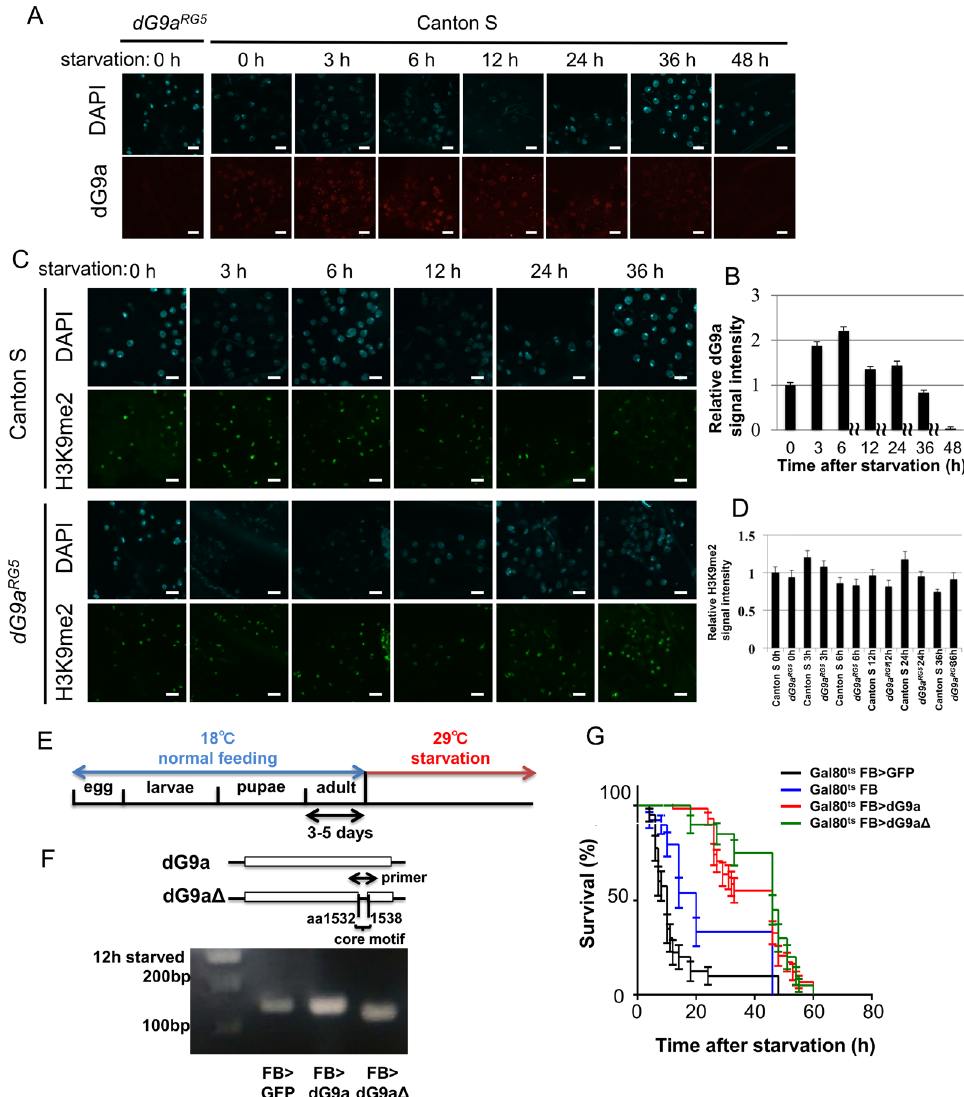
Figure 2. dG9a function in the fat body is critical for adult fly viability under starvation stress. ( A ) Transient induction of dG9a in the adult fat body under starvation conditions. Fat bodies of the wild-type and dG9a RG5 mutant were immunostained with an anti-dG9a antibody (red) and stained with DAPI (cyan). The dG9a RG5 mutant was used as a negative control. ( B ) Quantification of dG9a signals in nuclei of the wild-type fat body. Values were adjusted by subtracting background fluorescence n = 10. ( C ) Quantification of H3K9me2 signals in nuclei of the wild-type and dG9a RG5 mutant fat bodies. Values were adjusted by subtracting background fluorescence (n = 10). ( D ) H3K9me2 signal in the adult fat body under starvation conditions. Fat bodies of the wild-type and dG9a RG5 mutant were immunostained with an anti-H3K9me2 antibody (green) and stained with DAPI (cyan). ( E ) The experimental design of dG9a overexpression under starvation conditions. ( F ) Confirmation of dG9a and dG9a Δ 1532–1538 overexpression by semi-quantitative RT-PCR after 12 h of starvation. The primer included the core motif of the SET domain of dG9a. dG9a was more strongly expressed in FB > dG9a (FB-GAL4/GAL80 ts. α Tub84B ; UAS-dG9a/ + ) than in FB > GFP (a control: FB-GAL4/GAL80 ts. α Tub84B ; UAS-GFP/ + ). The amplicon size is 142